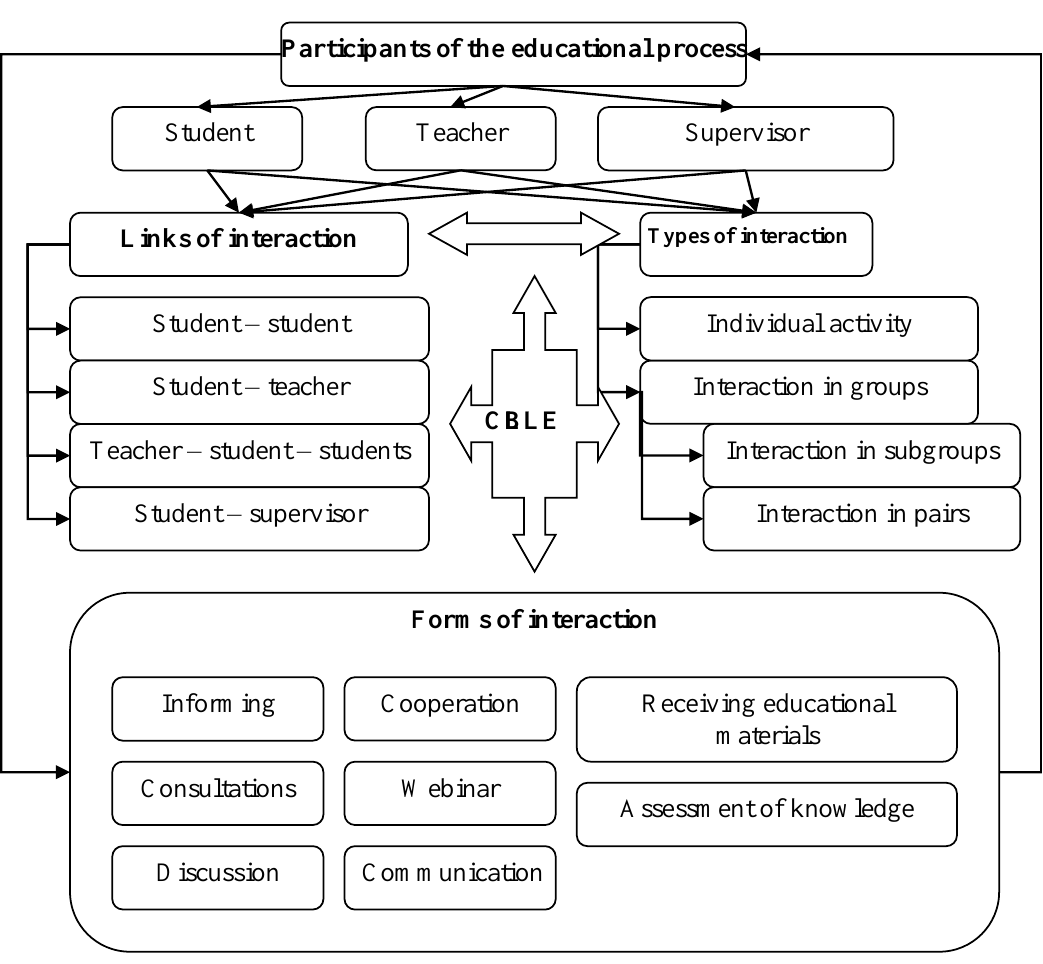
Figure 2: Model of interaction between students and teachers in a cloud-based learning